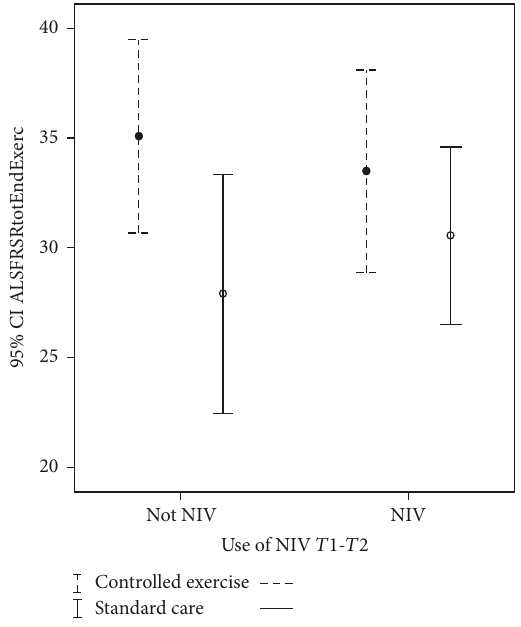
Figure 3: Influence of use of NIV on ALSFRS-R at end of study, Confidence Interval 95% ( −